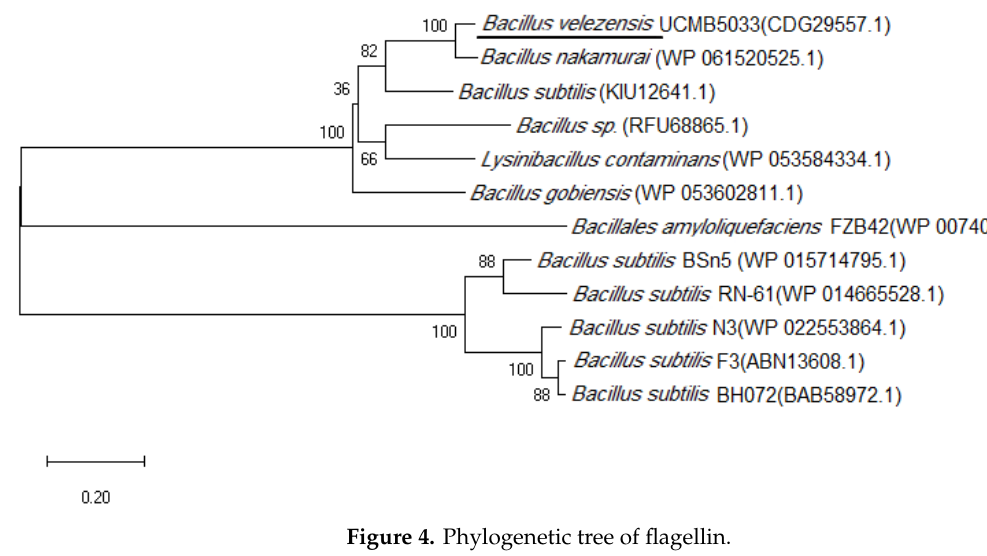
Figure 4. Phylogenetic tree of Figure 4 Phylogenetic tree of flagellin